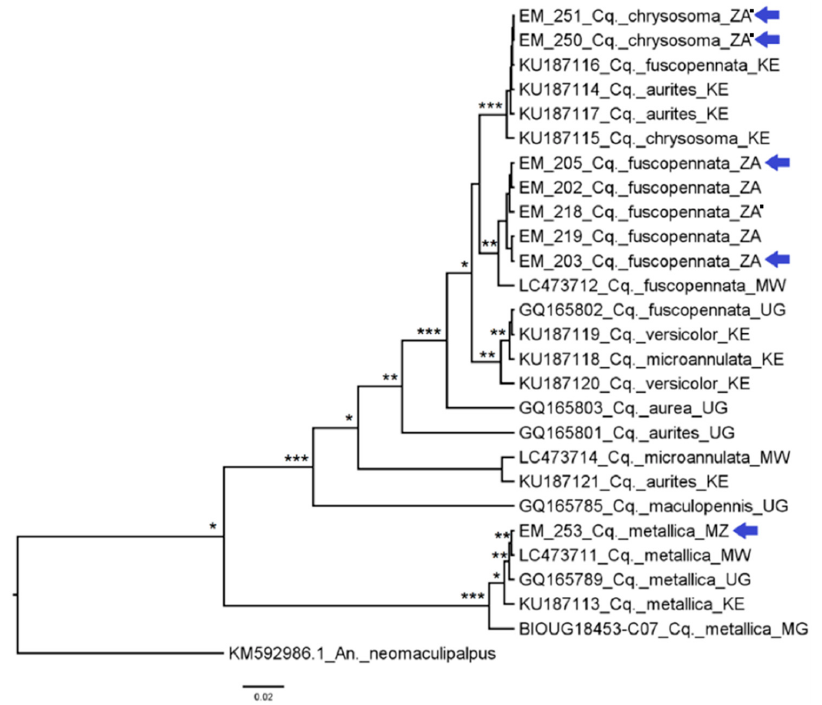
Figure 16. Phylogenetic analysis of 26 partial coxI nucleotide sequences from mosquitoes of the genus Coquillettidia. At specific branches, the number of * indicates the tree topological support revealed by the different phylogenetic reconstruction methods, assuming relevant bootstrap and aLRT values above 75% and posterior probability values above 0.80. The sequences obtained in this work are indicated by the “EM” code and those with associated genitalia are indicated by horizontal blue arrows. The sequences downloaded from GenBank and Boldsystems are indicated by their respective accession numbers and access codes (respectively); the symbol “.” after the code of our sequence indicates that said sequence was not identified by Boldsystems. Their country of origin [South Africa (ZA), Madagascar (MG), Malawi (MW), Mozambique (MZ), Kenya (KE), Uganda (UG)] are also indicated.